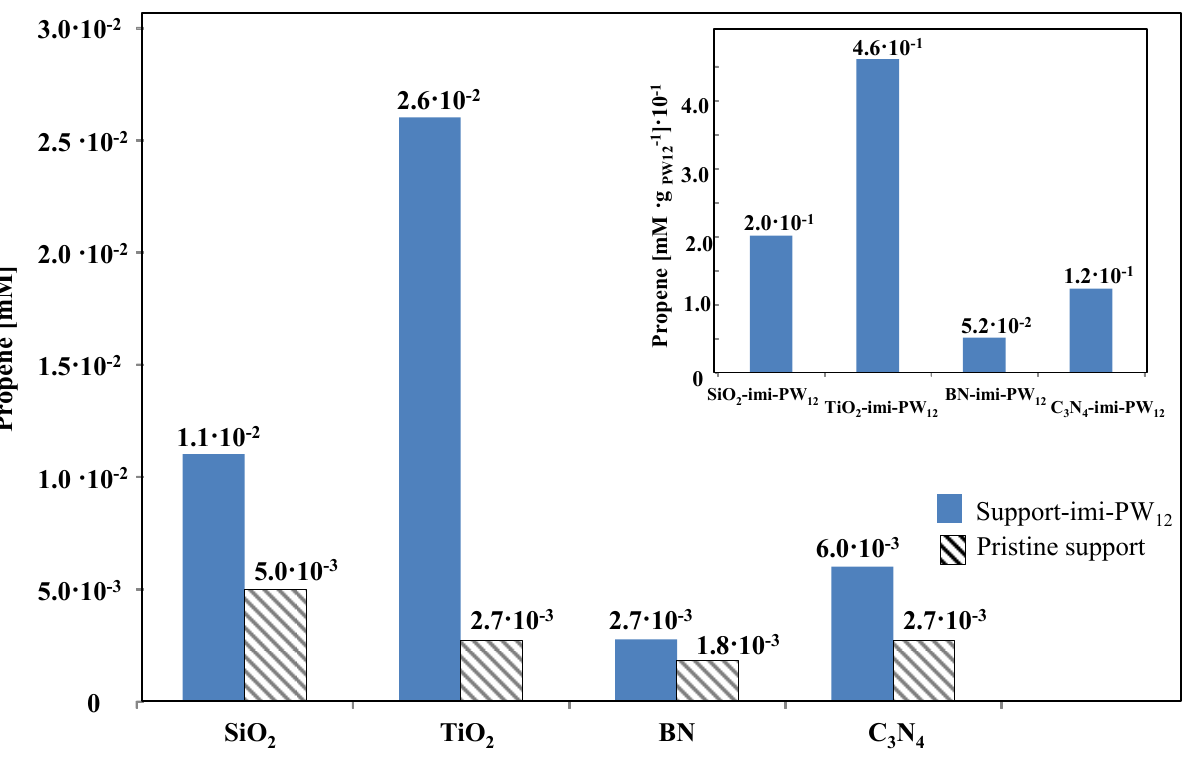
Figure 5. Propene amount measured in the atmosphere of the batch reactor after the 2-propanol catalytic dehydration, carried out for 120 min at 120 °C in the presence of 0.1 g of solid catalyst. (Inset) propene obtained per gram of PW 12 .